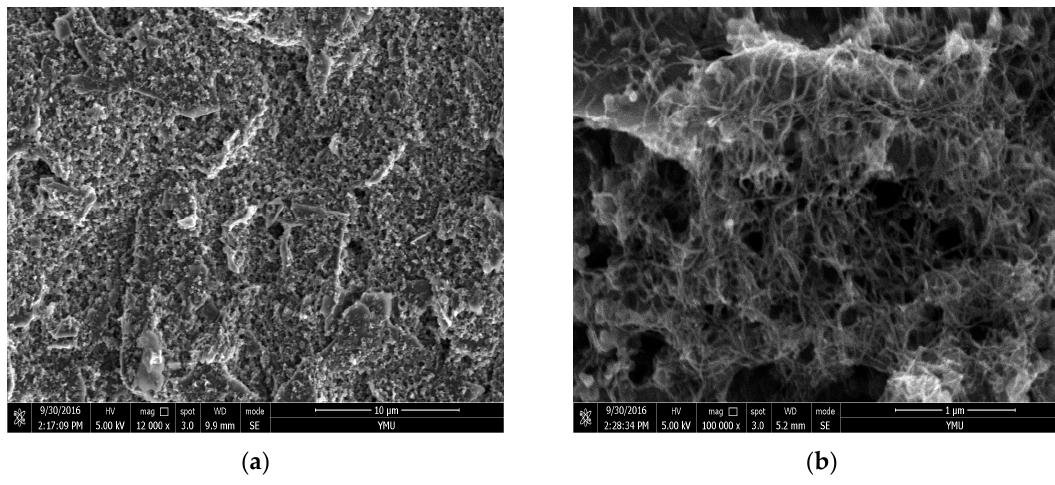
Figure 3. The SEM comparasion of bare screen-printed electrode (SPE) ( a ) and the multi-walled carbon nanotubes modified screen-printed electrode ( b ).